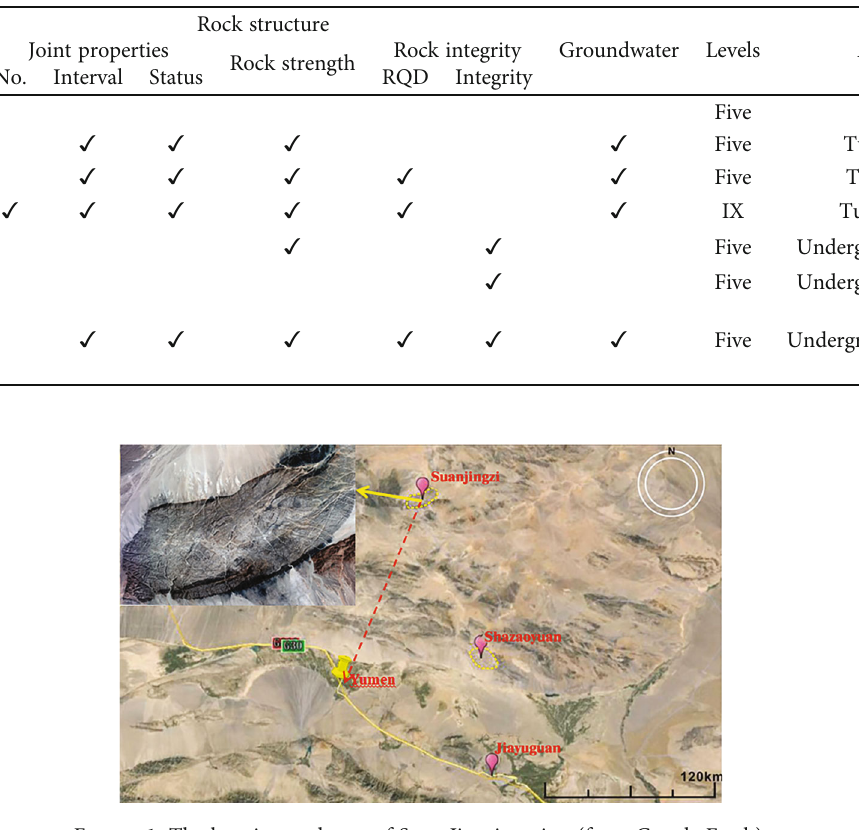
Figure 1: The location and area of Suan Jingzi section (form Google Earth).